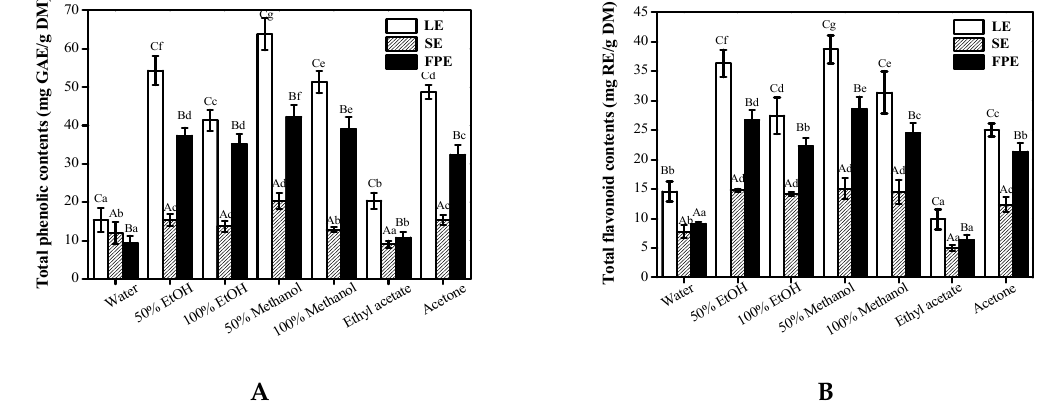
Figure 1. The e ff ects of extraction solvents on total phenolic contents ( A ) and total flavonoid contents ( B ) in various parts of raspberry. LE, leaves extracts; SE, seeds extracts; FPE, fruit pulp extracts;